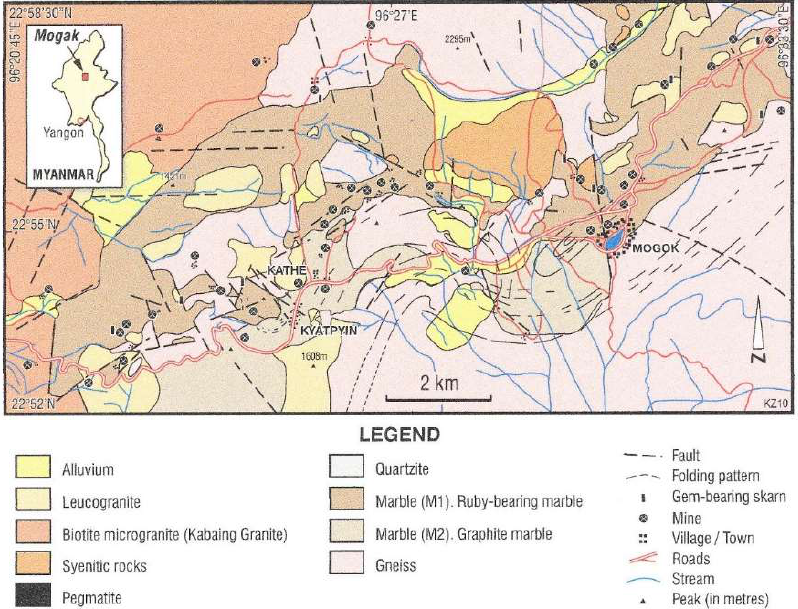
Figure 2. Geological map of Mogok Gem Tract, modified from reference [11], showing main lithological units and general distribution of gem deposits. The Thurein Taung workings lie ~4 km East of the 96°20’45” E longitude map border and 2.3 km North of the 22°52’ N latitude map border.